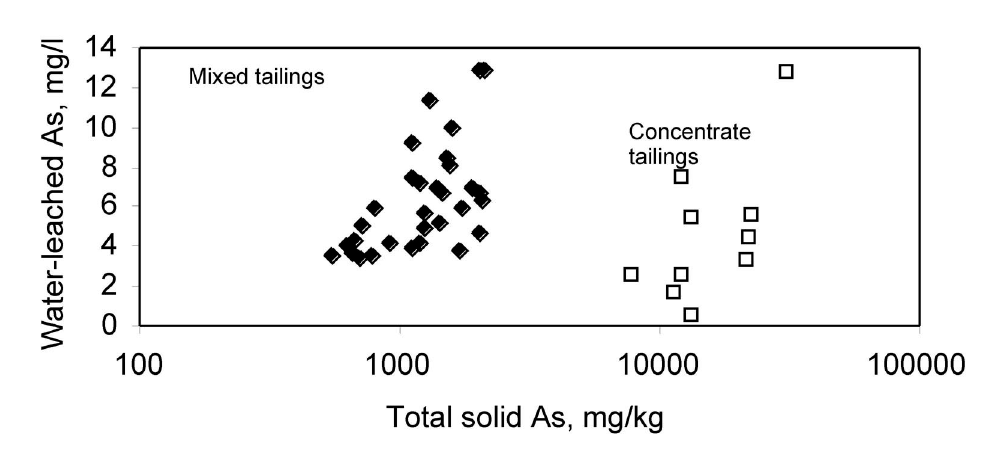
FIGURE 7. Concentrations of dissolved As leached with distilled water from Macraes mine tailings samples, in relation to total solid As concentrations in mixed tailings (black squares) and concentrate tailings (open